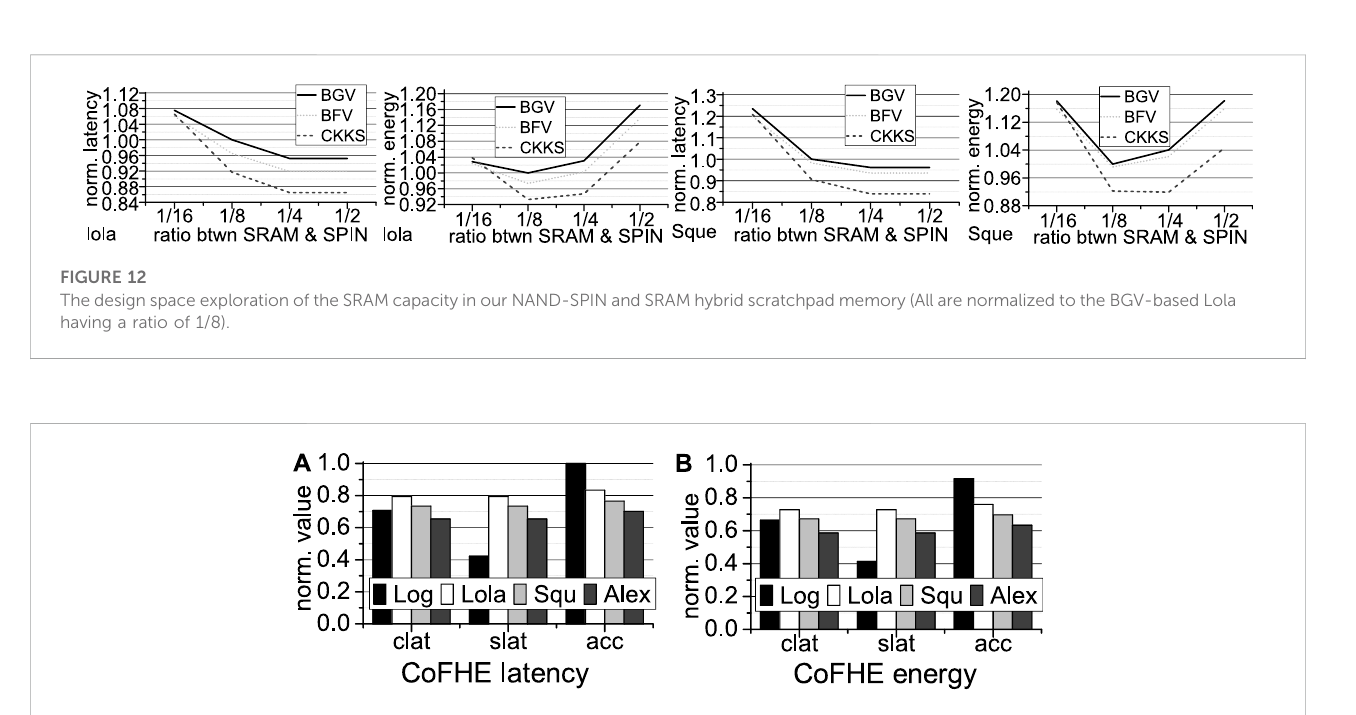
FIGURE 13 The inference latency and energy of CoFHE (A) : CoFHE latency; (B) : CoFHE energy; all are normalized to CKKSBTS; clat: client latency; slat: server latency; and acc: accuracy.